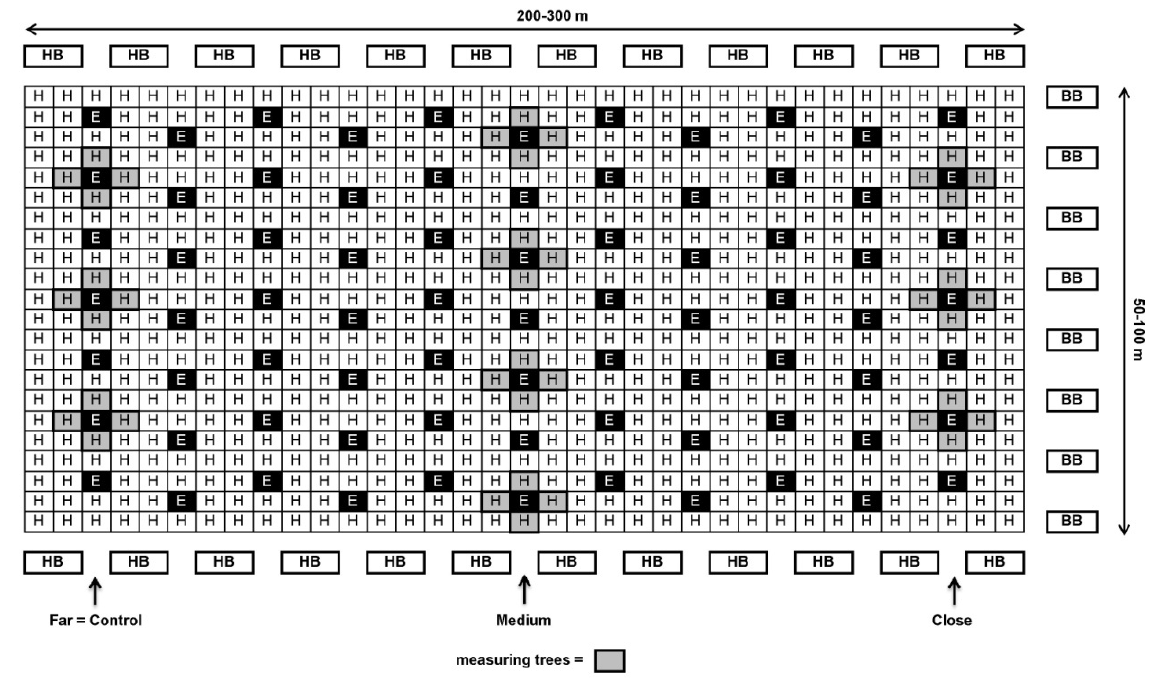
Figure 2. Schematic design of ‘Ettinger’ and ‘Hass’ plot at a 1:9 ratio (Kfar Hanassi and Eyal) with honeybee (HB) hives at the beginning and end of the rows and bumblebee (BB) hives on only one side of the orchard (right) or on both sides (not shown in the Figure). Close: 30–100 m; medium: 100–200 m; far: 200–300 m from BB hives.